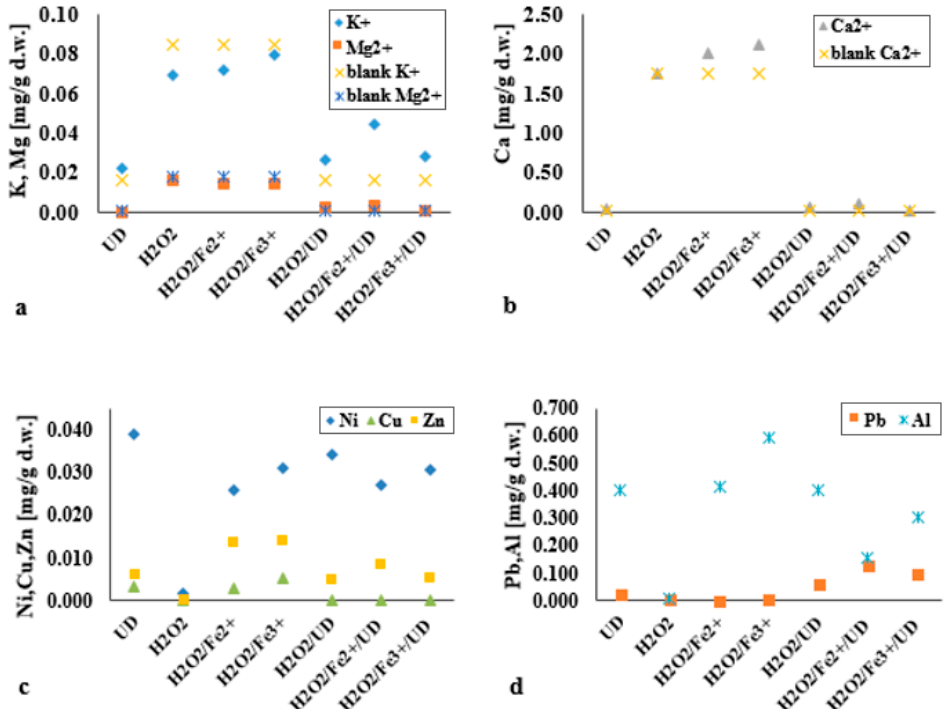
Figure 11. Leaching from bottom sediments of the selected macro-elements: ( a ) K + and Mg 2+ and ( b ) Ca 2+ ; ( c ) Ni, Cu and Zn; and ( d ) Pb and Al. Parameters: UD ( A = 30%, pH = 10, t = 60 min), H 2 O 2